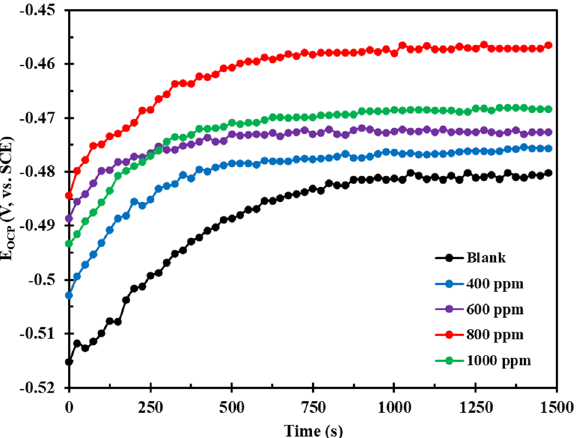
Figure 2. OCP vs time diagrams for MS submerged in an acidic solution without and containing different concentration of FV leaves